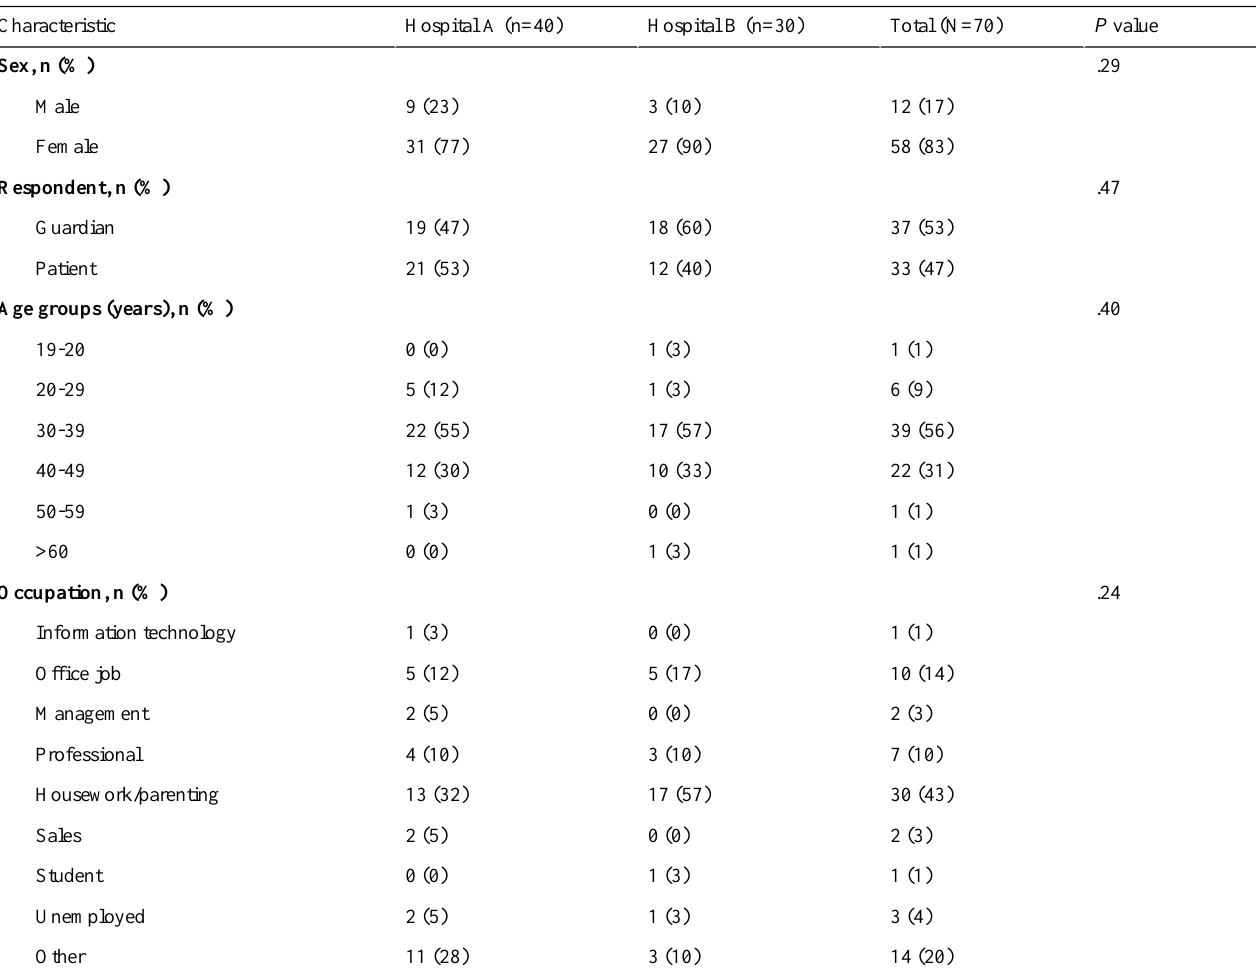
Table 1. Demographic characteristics of